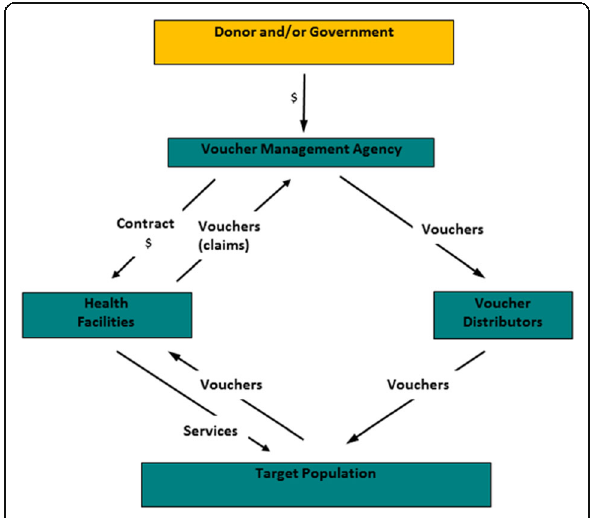
Fig. 1 Simplified structure of a voucher